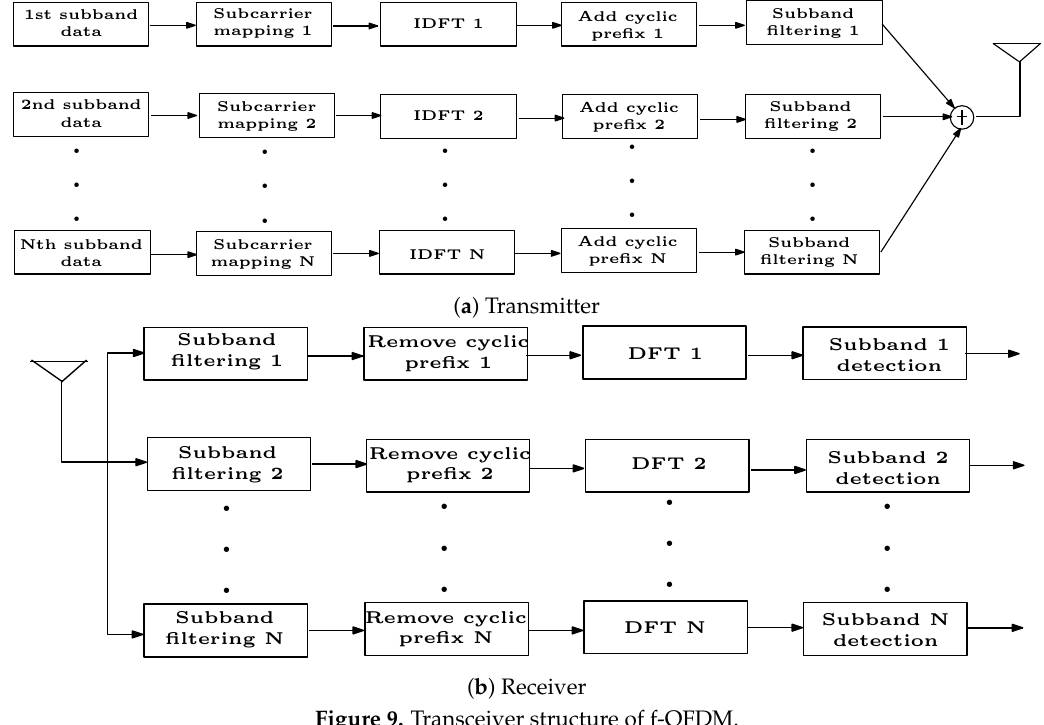
Figure 9. Transceiver structure of f-OFDM. Table 1. Comparison between CP-OFDM and f-OFDM based